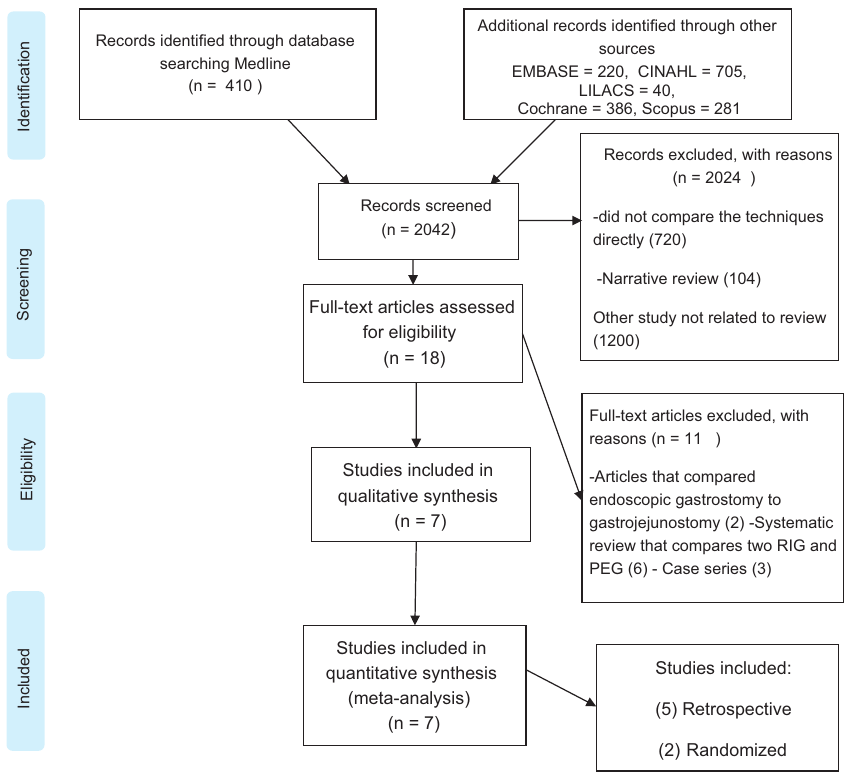
Figure 1 - Search strategy and selection of studies.